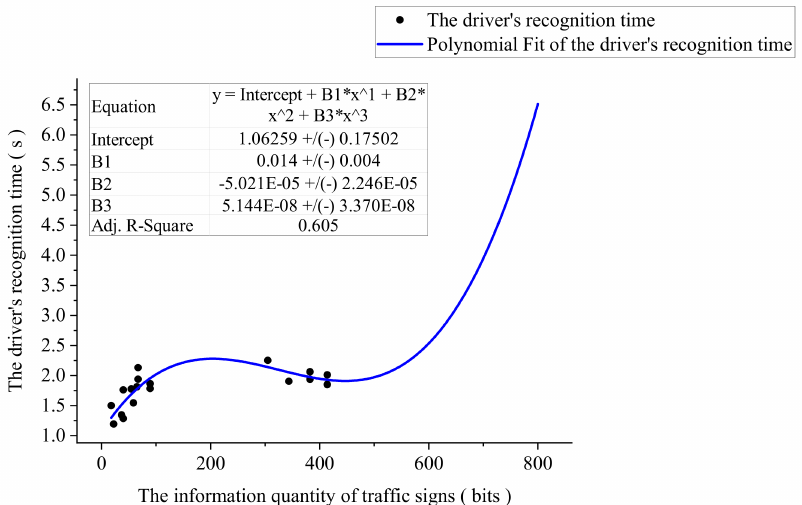
Figure 9. The visualization result of the model.